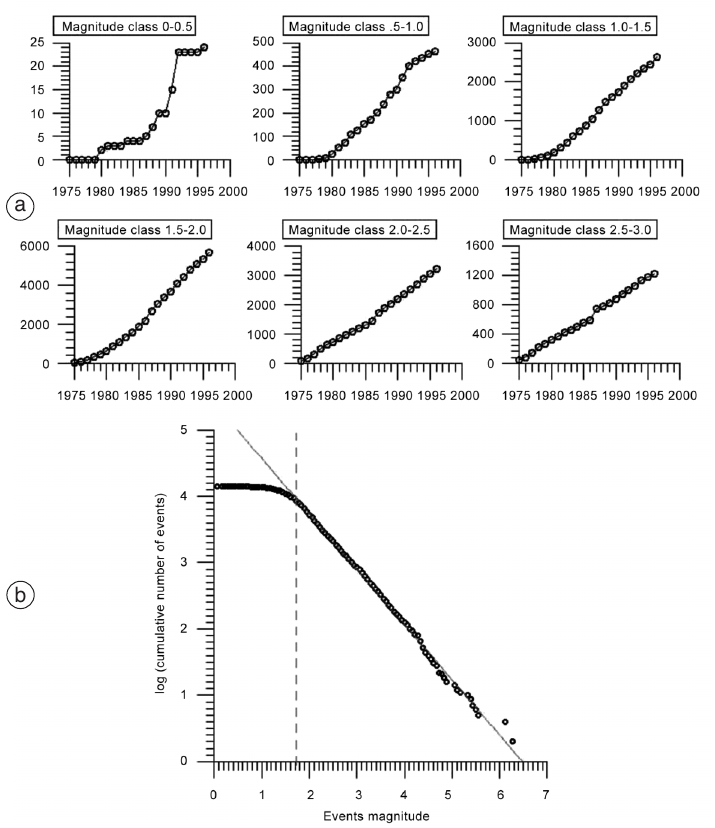
Fig. 1a,b. Results of the completeness analysis of the Ivtan Site seismic catalogue. a) Cumulative number of events versus time for magnitude class step = 0.5 for 0. < m > 3.0. Note that cumulative number of events is rescaled among magnitude classes. b) Log cumulative number of earthquake versus magnitude (Gutenberg- Richter relation) for the whole catalogue; values of regression fit equation: Y = − 0.83 ∗ X + 5.40 . Coefficient of de- termination, R -squared